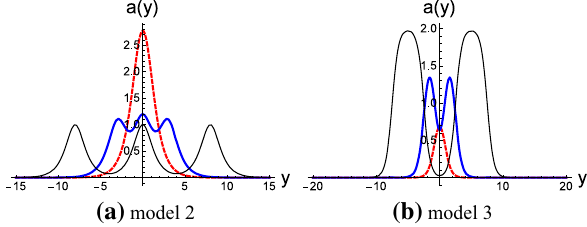
Fig. 2 The shape of the warp factor a ( y ) of the brane models 2 and 3. In a the parameters are set k = 1, and b = 0 . 5 for the dashed red line, b = 3 for the thick blue line, b = 8 for the thin black line. In b the parameters are set k = 1, and b = 0 . 2 for the dashed red line, b = 0 . 8 for the thick blue line, b = 2 . 5 for the thin black line a model 2 , b model